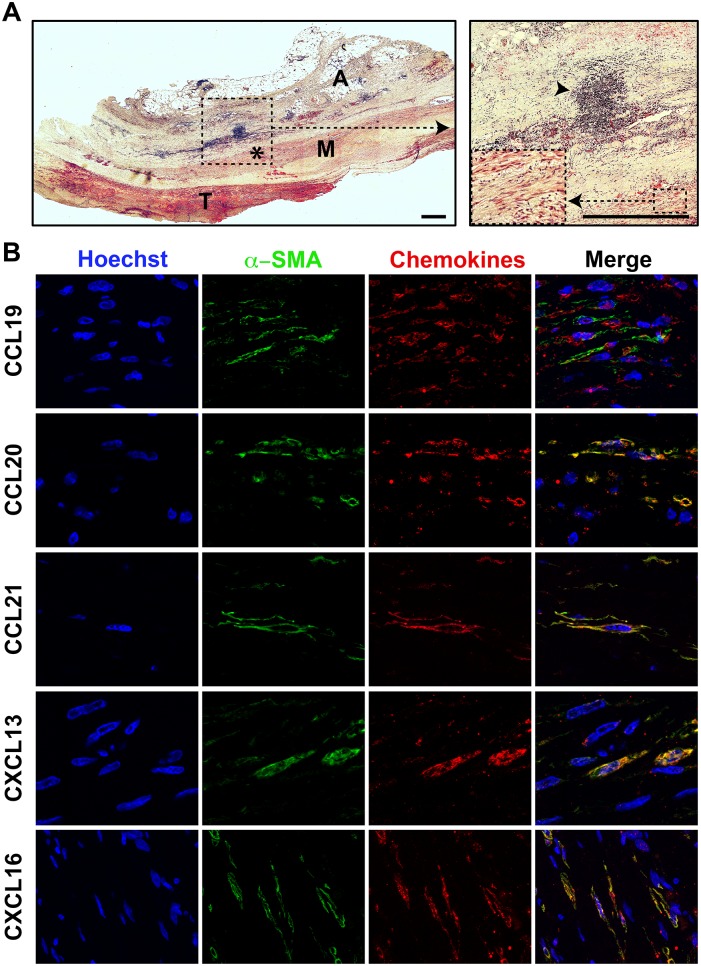
VSMCs in the vicinity of human aortic TLOs produce chemokines.(A) Masson’s trichrome staining performed on a human AAA cross-section. The dashed square indicates the area that is magnified on the right inset. The asterisk represents the smooth muscle cell-rich area that is magnified in the dashed square box in the right inset (M = media; A = adventitia; SLO = Secondary Lymphoid Organ; scale bar = 2 mm). (B) Representative immunohistochemical staining of α-SMA+ VSMCs (green), CCL19, CCL20, CCL21, CXCL13 and CXCL16 chemokines (red) and nuclei (DAPI, blue) performed on human AAA cryosections (scale bar = 50 µm; n = 5).